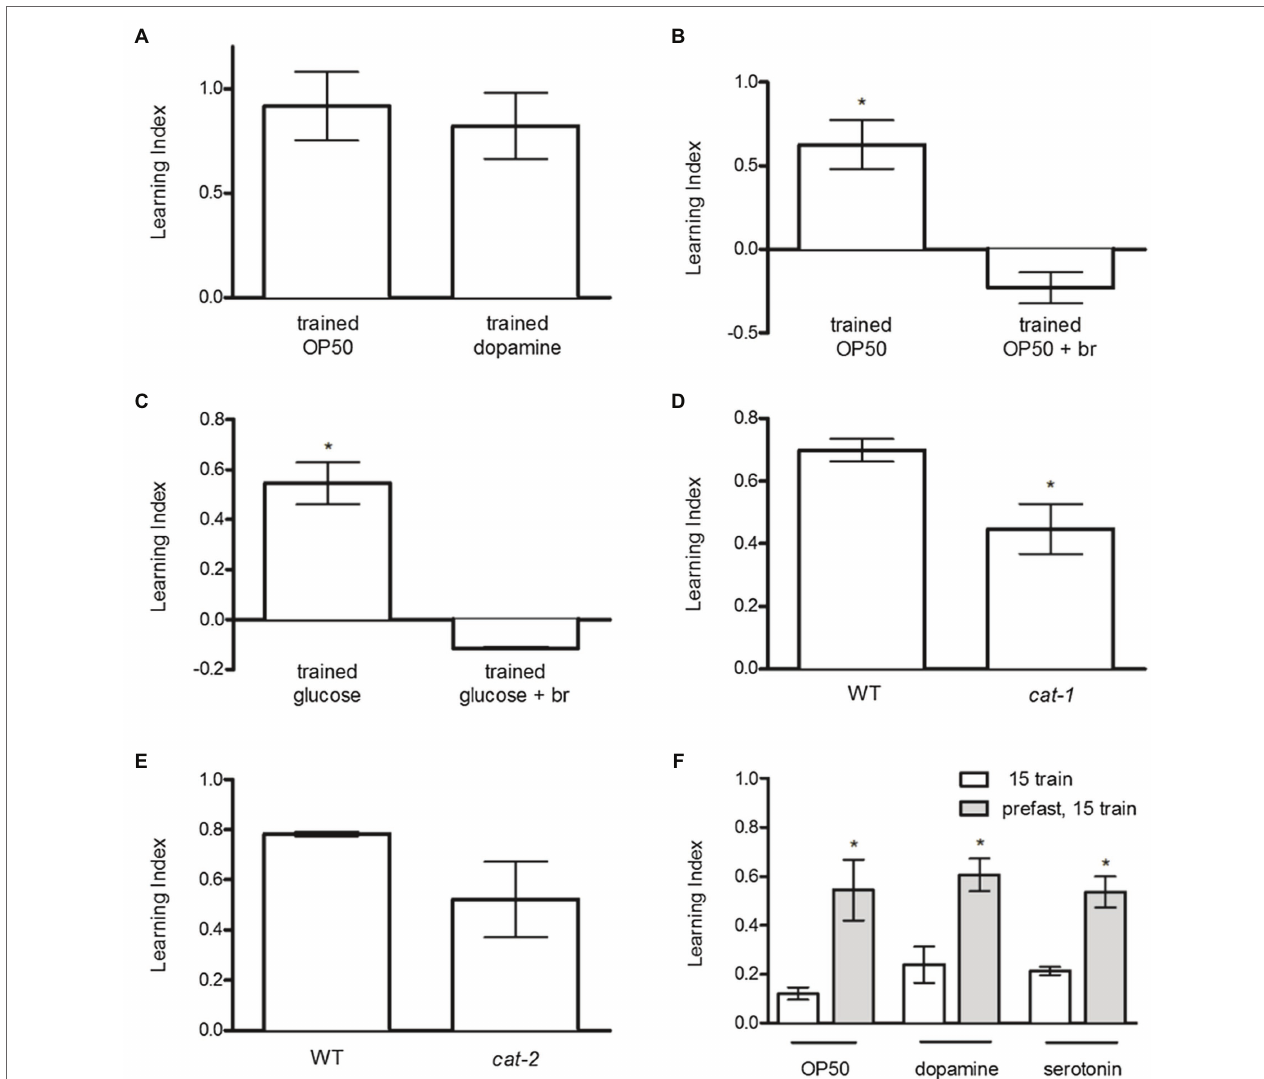
FIGURE 3 | Dopamine D1- and D2-like receptor signaling antagonistically regulates food and glucose-induced odor preference. (A) Exogenous DA increased odor preference similar to OP50. (B) Bromocriptine blocked odor preference induced by OP50 and (C) glucose. (D) cat-1 mutant worms exhibited decreased learning index compared to N2 animals. (E) The learning indices of cat-2 mutants and N2 animals were similar. (F) Fasting before training increased odor preference produced by food, dopamine, and serotonin similarly. * p < 0.05 ( t test). Each column represents at least 3 independent trials, using approximately 50–150 animals per